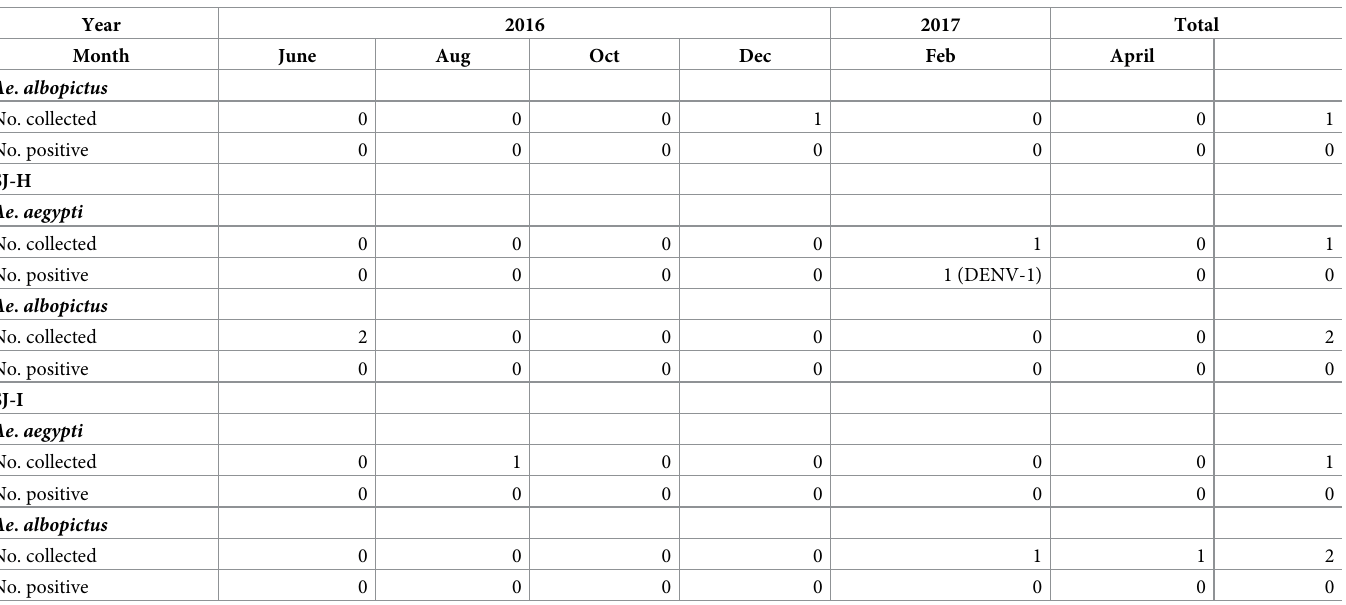
and another more recent isolate from China in 2015 (KU094071). Many DENV-1 strains iso- lated between the 1940s and 2010s from Southeast Asia also belong to this genotype, including Malaysian isolates from Johor Bahru (KX452068) and the Klang Valley (JN697058). The DENV-2 sequence BJI29-2/2016 obtained in this study was analysed with 32 reference sequences from six genotypes of DENV-2, namely the Asian I, Asian II, American/Asian, American and Cosmopolitan genotypes and included sylvatic strains isolated in Malaysia. Based on this analysis, we can confirm that the DENV strain sequenced from an Ae . albopictus larva collected from Kuala Lumpur in 2016 belonged to serotype 2. However, we are unable to conduct any further analysis to determine the genotype of the sequence due to the short sequence length. The DENV-3 (n = 13) sequences obtained in this study were analysed with 22 reference sequences (Fig 3) from genotypes I to V. Based on this analysis, all the sample sequences clus- tered with strains from genotype V, including with the first DENV-3 genotype V strain iso- lated in the Philippines in 1956 (M93130) [32,33] as well as with isolates that were detected in early Asian strains and were recently detected among patients during outbreaks in Brazil and Colombia [32]. The DENV-4 (n = 18) sequences obtained in this study were analysed with 16 reference sequences (Fig 4) from genotypes I to III as well as three sylvatic strains (genotype IV). Geno- type III is specifically found in neighbouring Thailand, with genotypes I and II represented by strains from Southeast Asia, Sri Lanka, the Caribbean and the Americas [13]. Phylogenetic analysis revealed that the sequences obtained from both Ae . aegypti and Ae . albopictus in this study belonged to the sylvatic genotype, clustering with early sylvatic isolates collected in the 1970s from the forest-dwelling Ae . niveus (EF457906), and from sentinel monkeys (JF262780 and JF262779) in Peninsular Malaysia